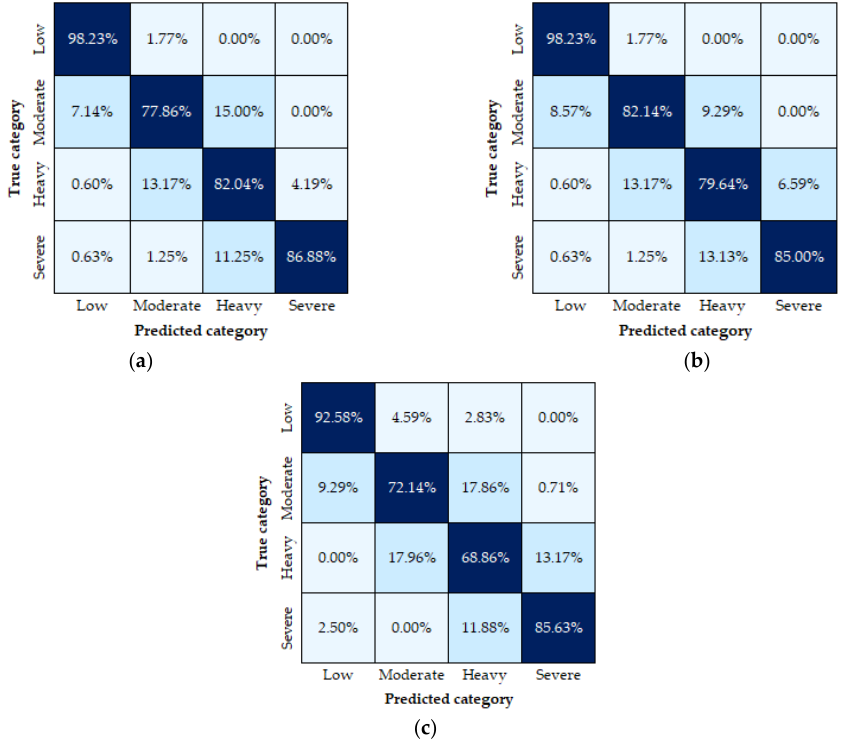
Figure 4. Confusion matrices: ( a ) using 10-fold cross-validation, ( b ) using stratified 10-fold cross- validation and ( c ) using group cross-validation with 24 splits.